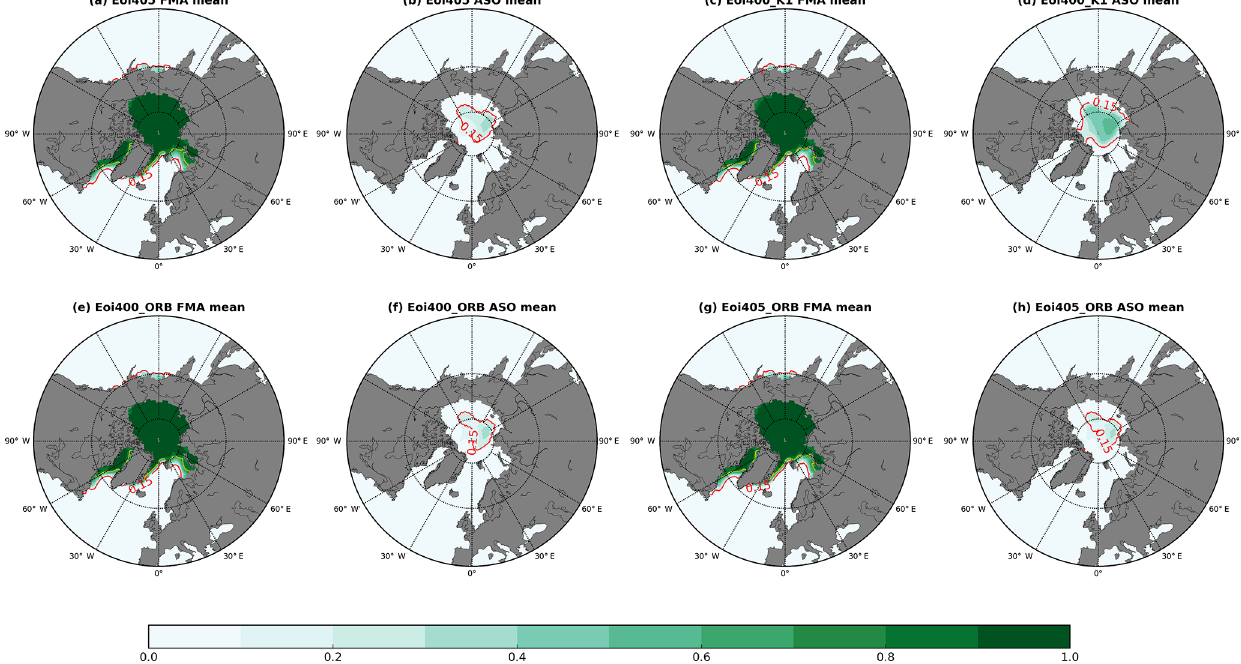
Figure 12. Seasonal mean Arctic sea ice concentration averaged over 100 model years as simulated by COSMOS for mid-Pliocene simula- tions in response to changes in PlioMIP’s prescribed boundary conditions. Panels (a) , (c) , (e) , and (g) show winter (FMA) averages, while panels (b) , (d) , (f) , and (h) show summer (ASO) averages for simulations Eoi405, Eoi400_K1, Eoi400_ORB, and Eoi405_GHG_ORG, respectively. The red contours indicate the 15% isoline of sea ice cover, while yellow contours indicate the 75% isoline of sea ice